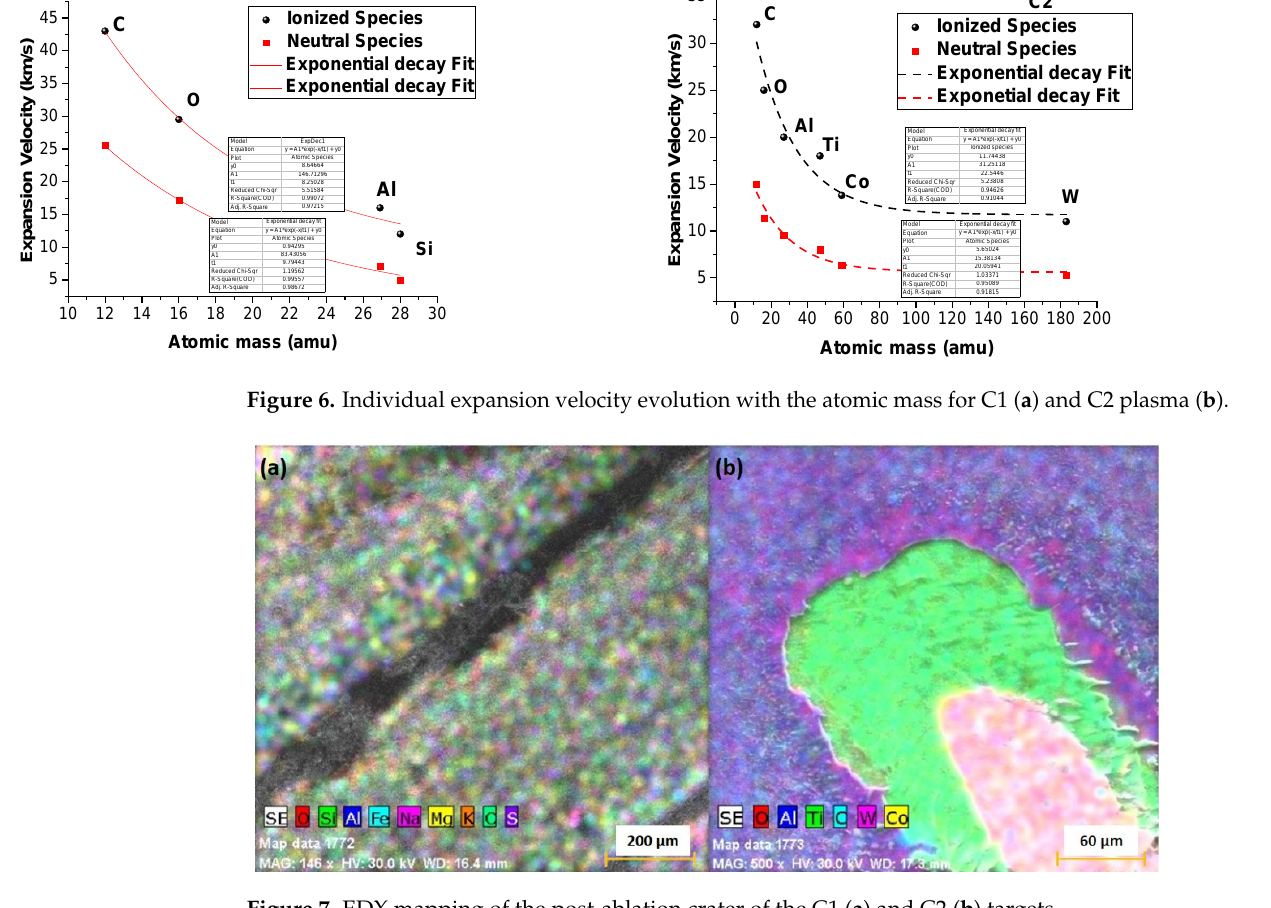
thin layer composition was: Fe: 84.8 (detector error: 1.23%), O: 6.25 (detector error: 1.16%),